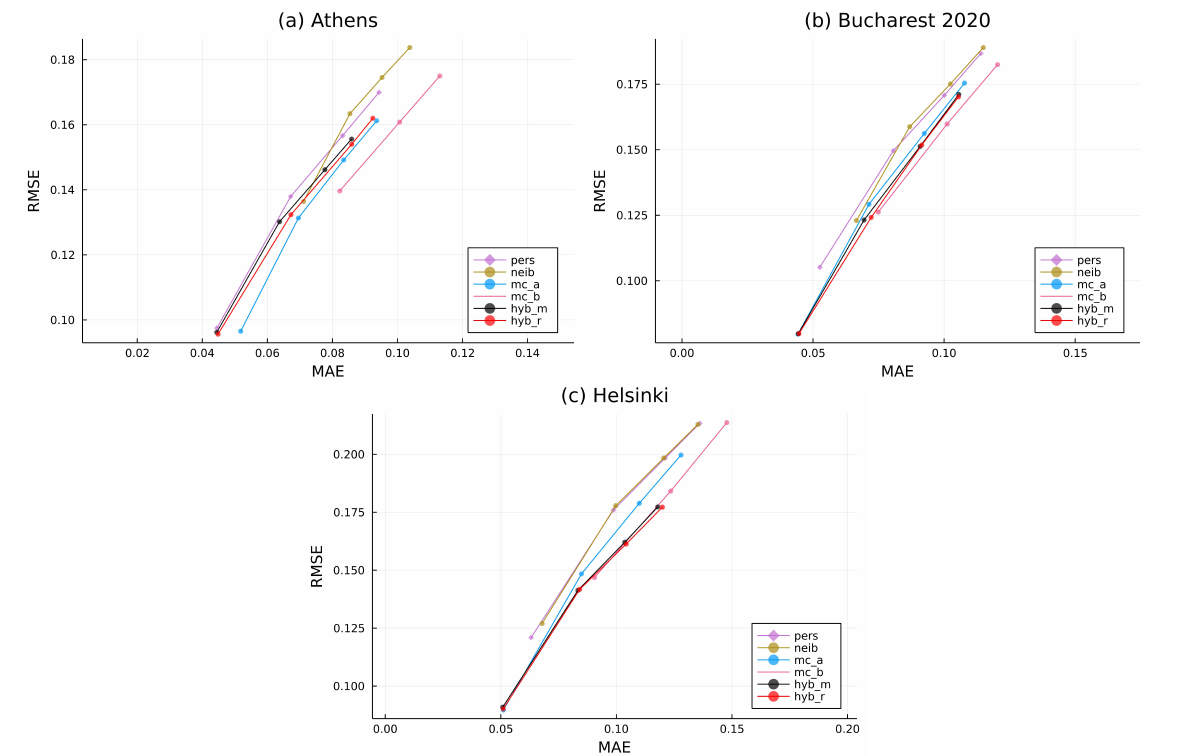
Figure A3. Mean absolute error (MAE) verses root mean square error (RMSE) for ( a ) Athens, ( b ) Bucharest, and ( c ) Helsinki.